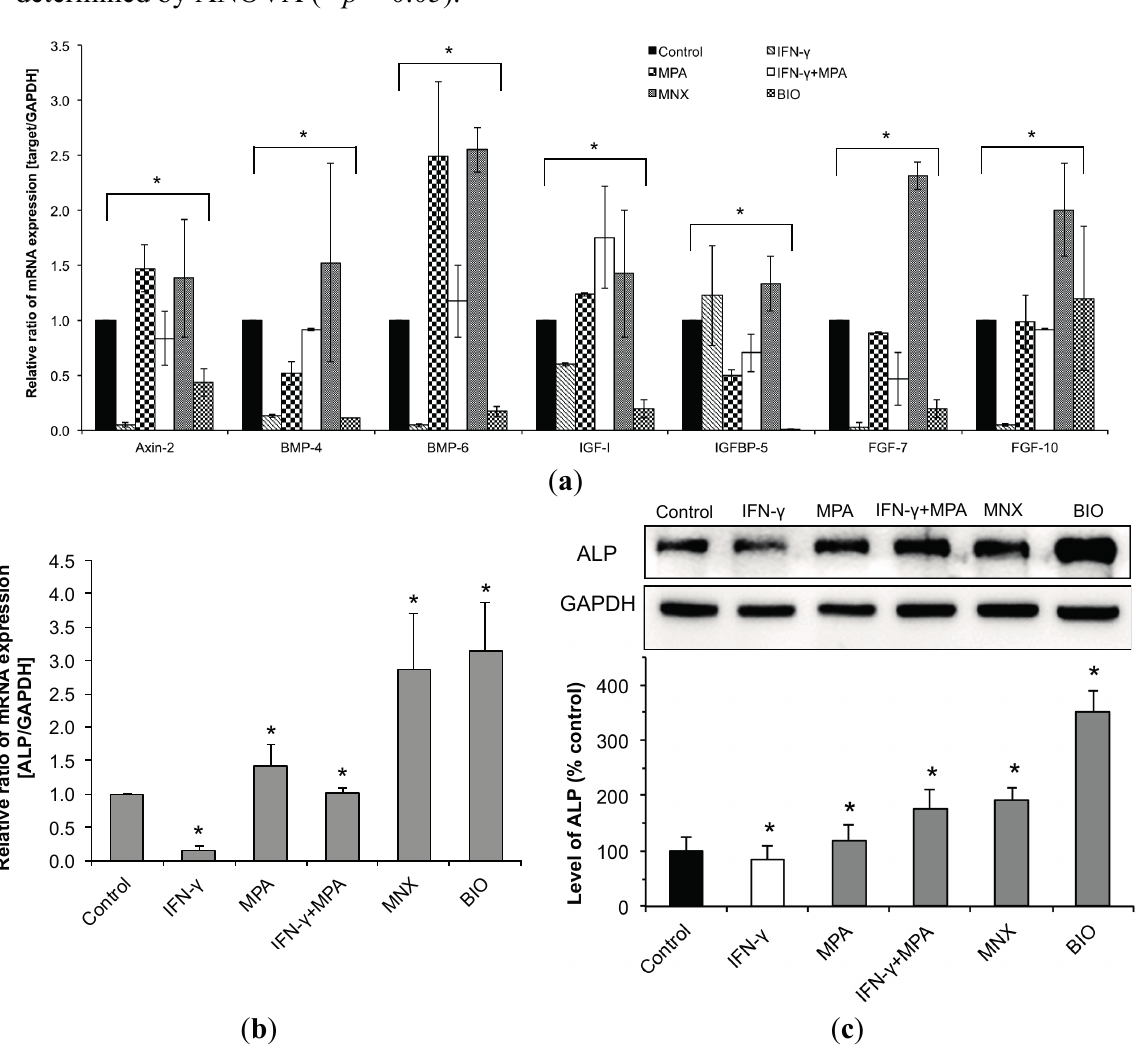
Figure 4. Effects of MPA on the expression of β -catenin target genes, DP signature genes, and alkaline phosphatase (ALP) in IFN- γ -treated hDPCs. mRNA expression was measured by real-time RT-PCR using appropriate primers, as described in “Materials and Methods”. The relative intensity of each mRNA expression was normalized with GAPDH. mRNA expression of DP signature genes ( a ), β -catenin target genes ( a ), and ALP ( b ) are shown; and ( c ) The protein level of ALP was examined by Western blot using a specific anti-ALP antibody, and its relative level is shown as mean ± SD from three independent experiments. MNX and BIO served as positive controls for expression of DP signature genes, β -catenin target genes, and ALP. Statistically significant differences were determined by ANOVA ( * p < 0.05).